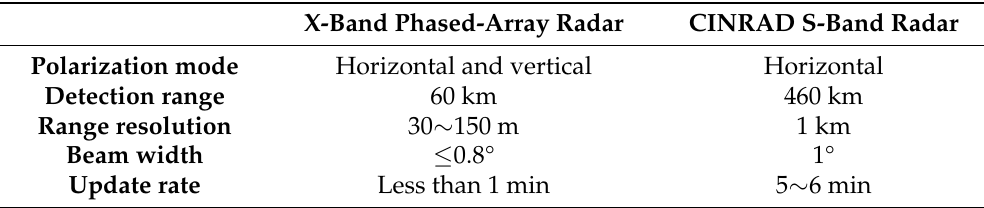
Table 1. The system specifications of the X-band phased-array radar vs. CINRAD S-band